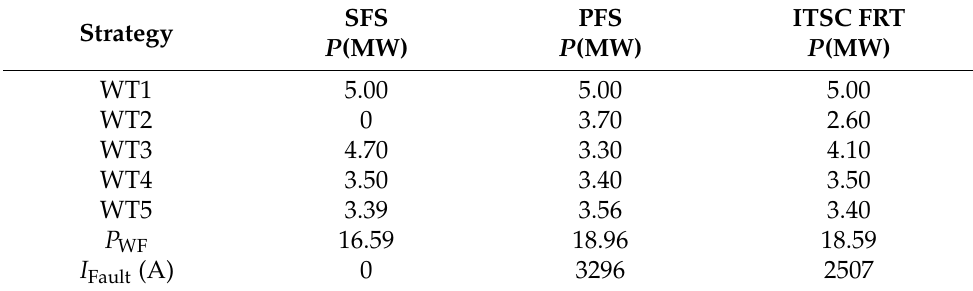
Table 3. Power and faulty phase current under the SFS, PFS, and ITSC FRT strategies.